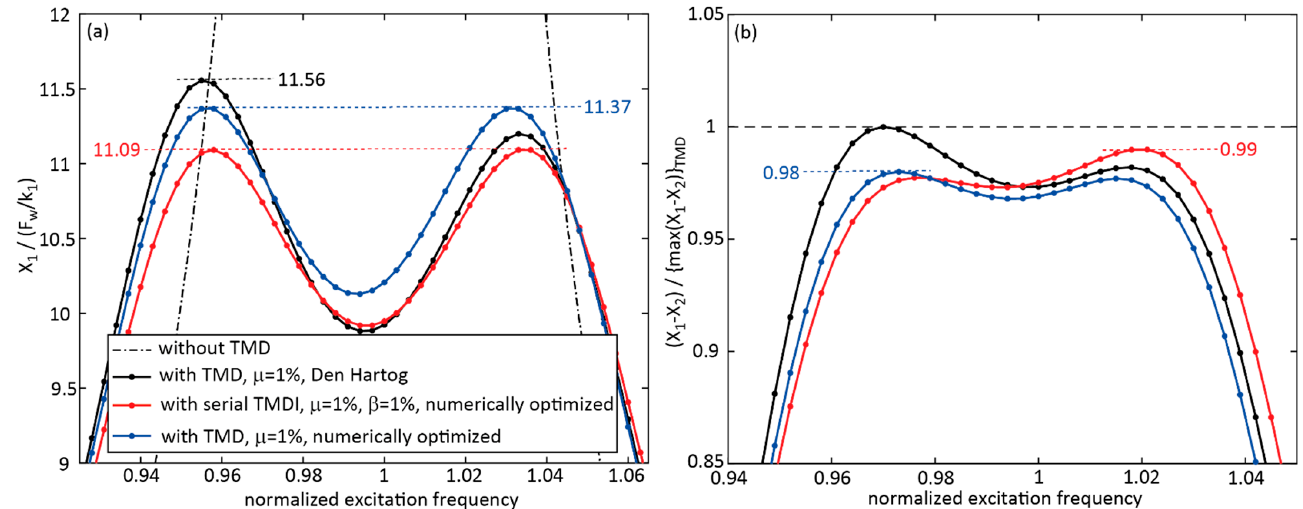
Figure 10. Performances of TMDI with serial arrangement of stiffness, inerter and damper ( 𝜇 = 1%, 𝛽 = 1%, numerically optimized parameters), TMD ( 𝜇 = 1%, Den Hartog parameters) and TMD ( 𝜇 = 1%, numerically optimized parameters) for harmonic excitation: ( a ) primary structure normalized displacement response and ( b ) normalized damper relative motion